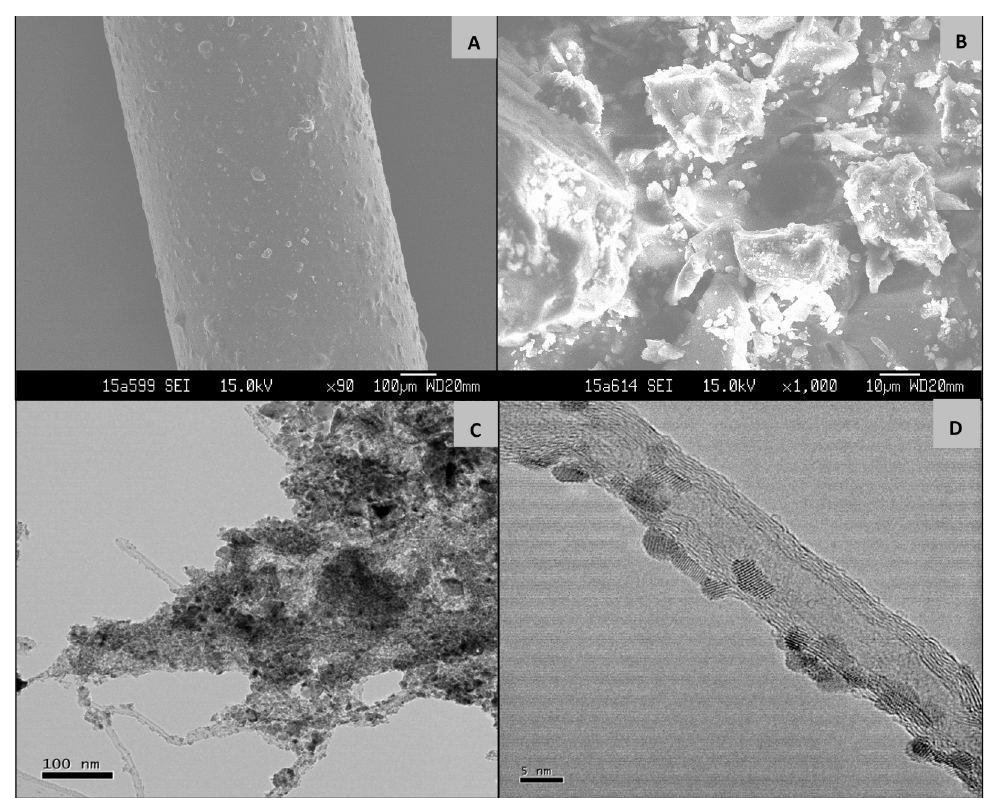
Figure 4. SEM images of GCT ( A ) fiber, ( B ) powder and TEM images of ( C – D ) GCT